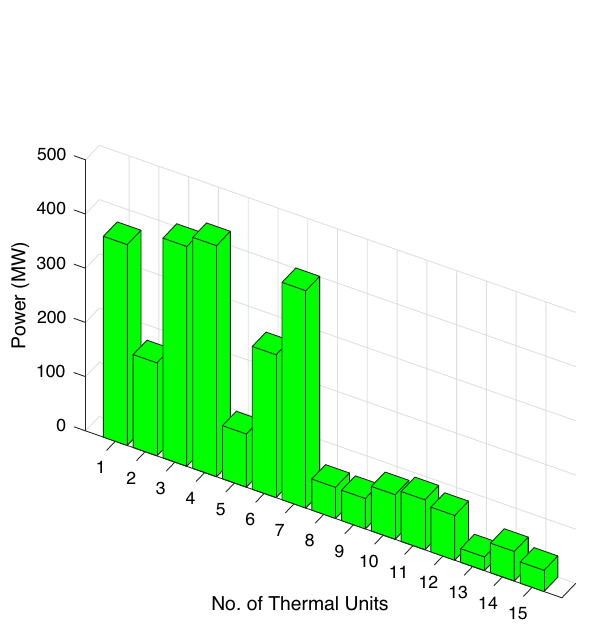
Figure 13. Optimum power generations for case